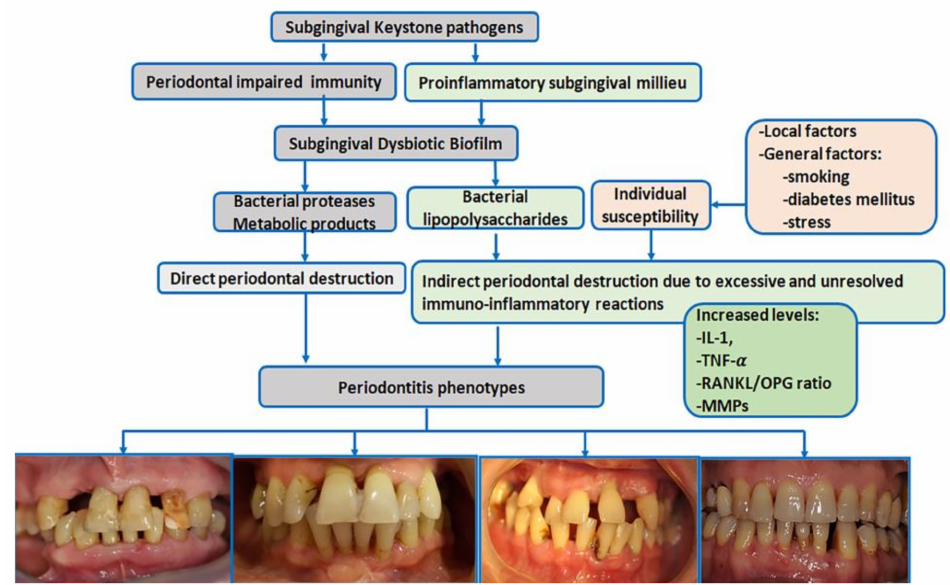
Figure 1. Schematic view of periodontitis pathogenesis (IL-1 = interleukin-1, TNF- α = tumor necrosis factor α , RANKL = receptor activator of nuclear factor kappa-B ligand, OPG =